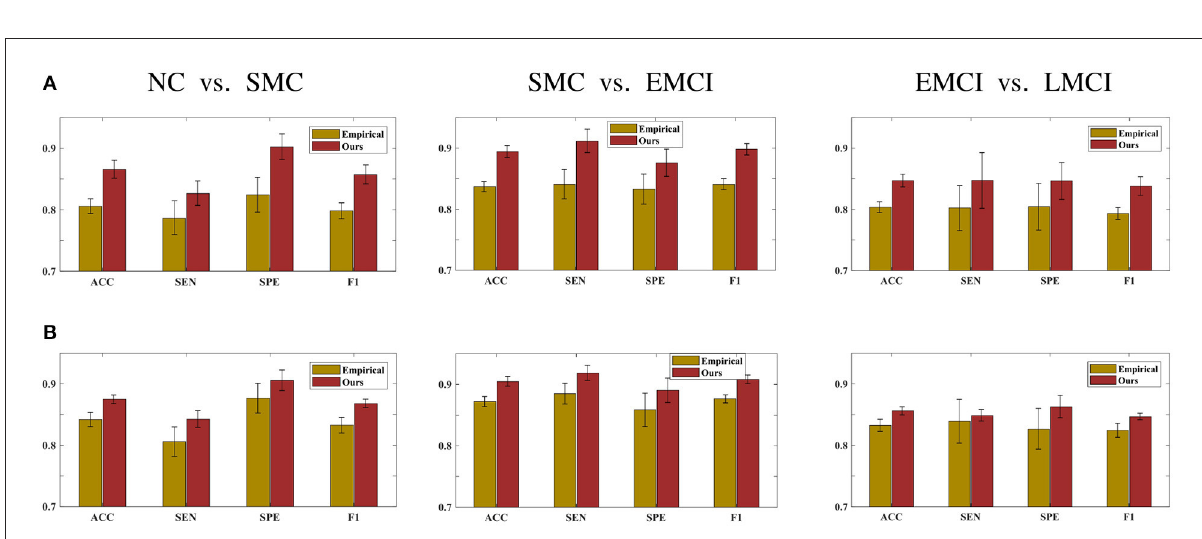
FIGURE6 Prediction results of three scenarios tasks using (A) the SVM classifier and (B) the GCN